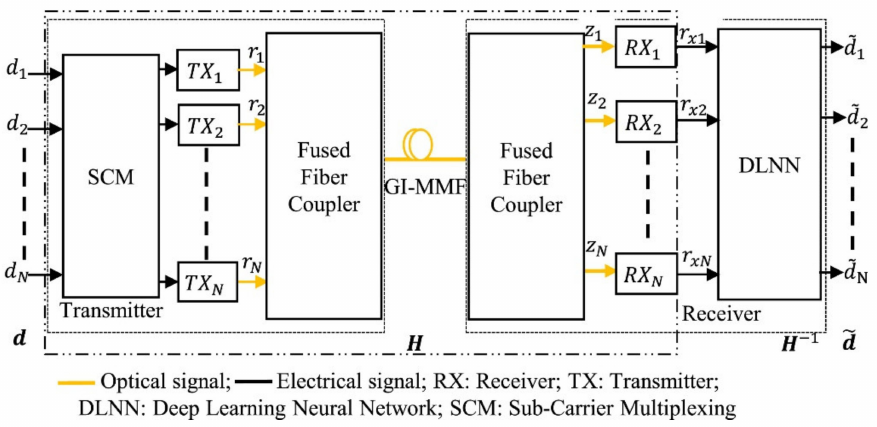
Figure 22. MDM transmission system based on DLNN.